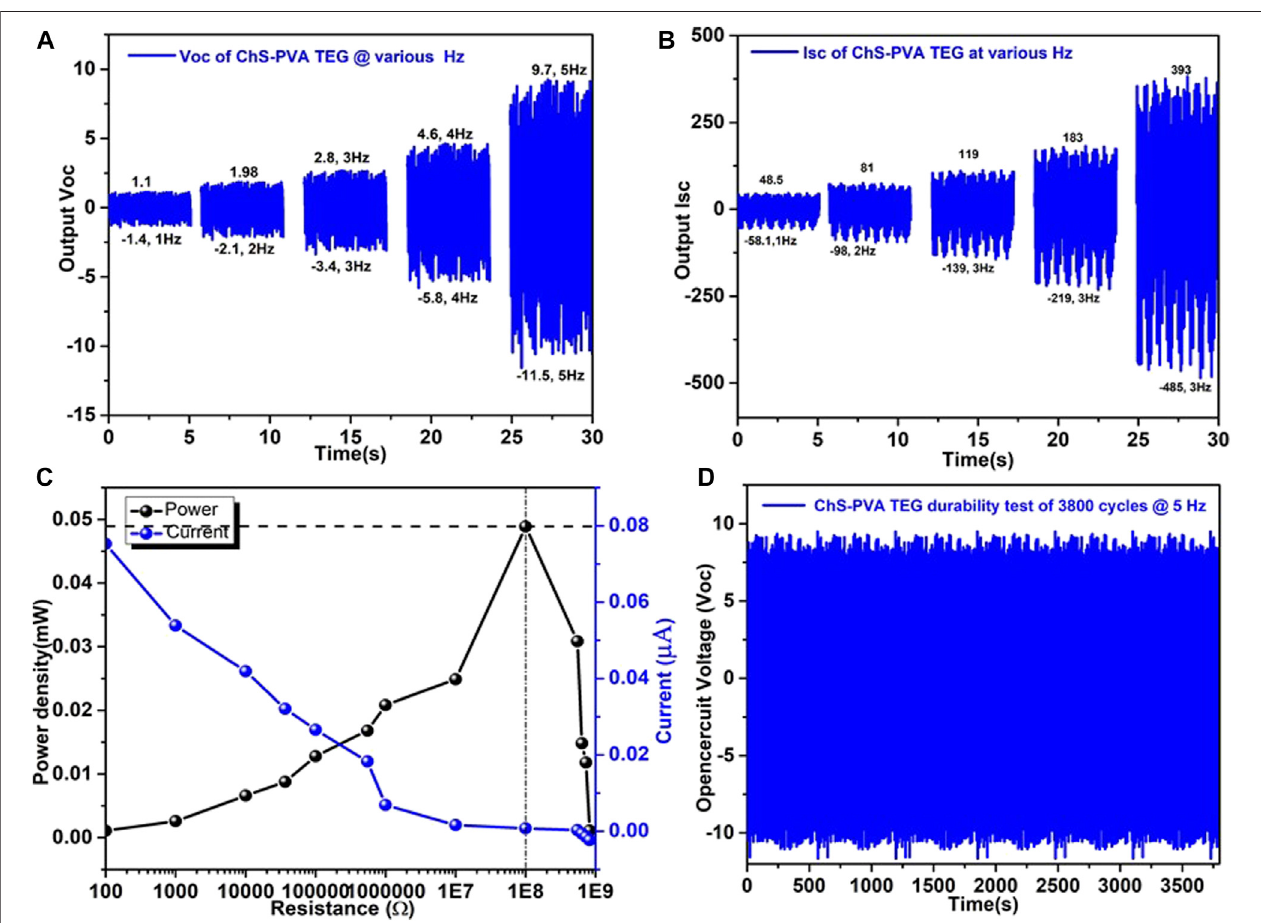
FIGURE7| TheoutputperformanceoftheChS-PVA TENG at various speeds ofvarious frequenciesusing a contact separation mode mechanical device (A) Voc; (B) Isc; and (C) the comparison of Isc (µA) and power density (mW) under different applied frequencies of the ChS-PVA TENG.